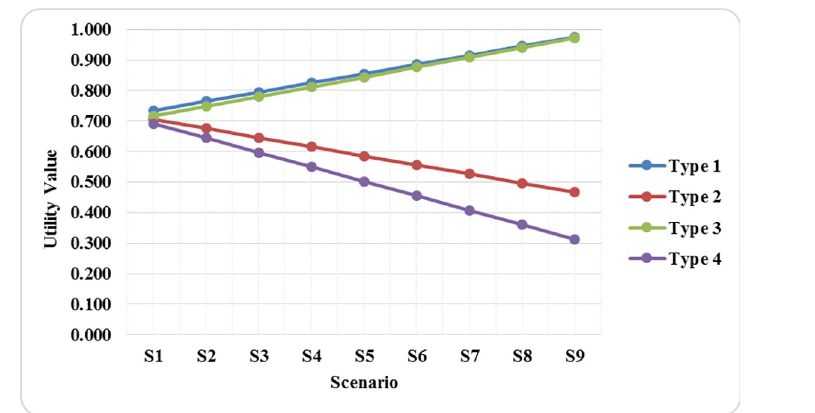
Fig 10. Utility values chart regarding each scenario.